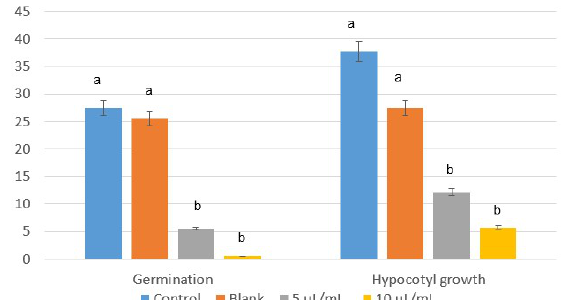
Figure 5. In vivo effect of the emulsifiable concentrate of winter savory essential oil over the germination and hypocotyl growth of tomato seeds. Values are mean of ten replications ± error deviation after 30 days of incubation. Means followed by different letters in the same column indicate that they are significantly different at p < 0.05 according to T3 Dunnet and Tukey tests.